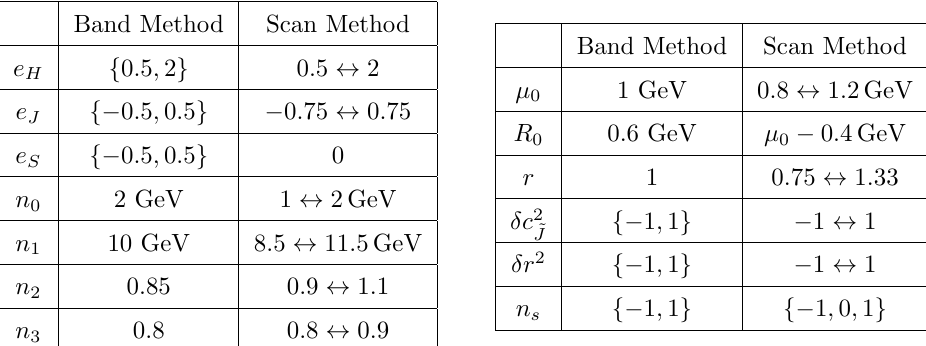
Table 7 . Central values and/or parameter ranges we use in the band and scan methods described in section 5.2. For the band method, the lists of parameters are discrete variations whose results are added in quadrature. For the scan method, all parameters are chosen randomly within the ranges shown. It is important to remember that the range of values chosen for any given parameter need not be identical in the two independent approaches we use to estimate the theoretical